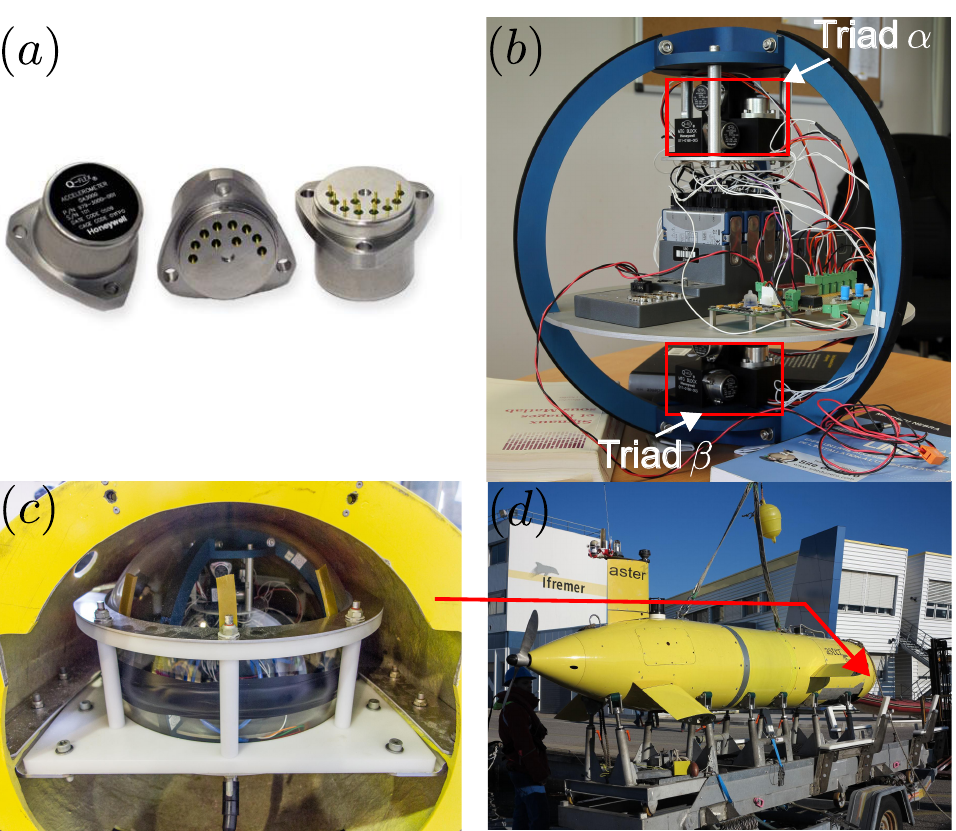
Figure 1. ( a ) QFLEX QA-3000 electrostatic accelerometers manufactured by Honeywell. ( b ) Picture showing GraviMob’s accelerometer sensor and its 24 bit digitiser. The two triads α and β each consisted of 3 accelerometers, the axes of which are mutually orthogonal and are shown in the red boxes. ( c ) Picture showing the glass sphere mounted in its frame itself screw-fixed into the AUV’s front case. ( d ) Overall view of AUV Aster x . The red arrow points to the front case where the sensor was